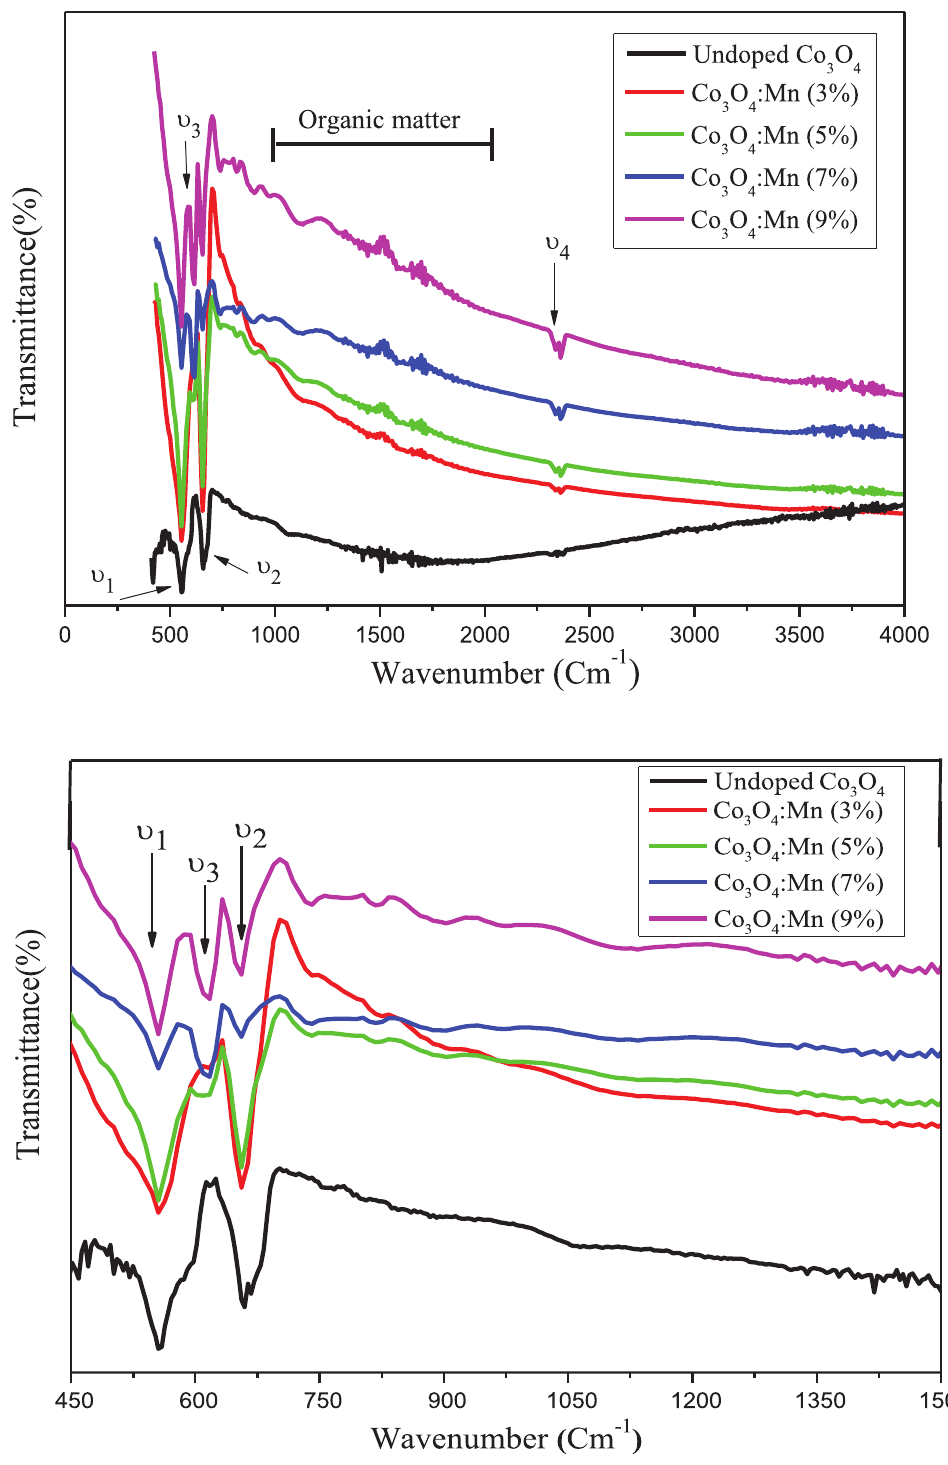
Figure 8: FTIR spectra of Mn-doped Co 3 O 4